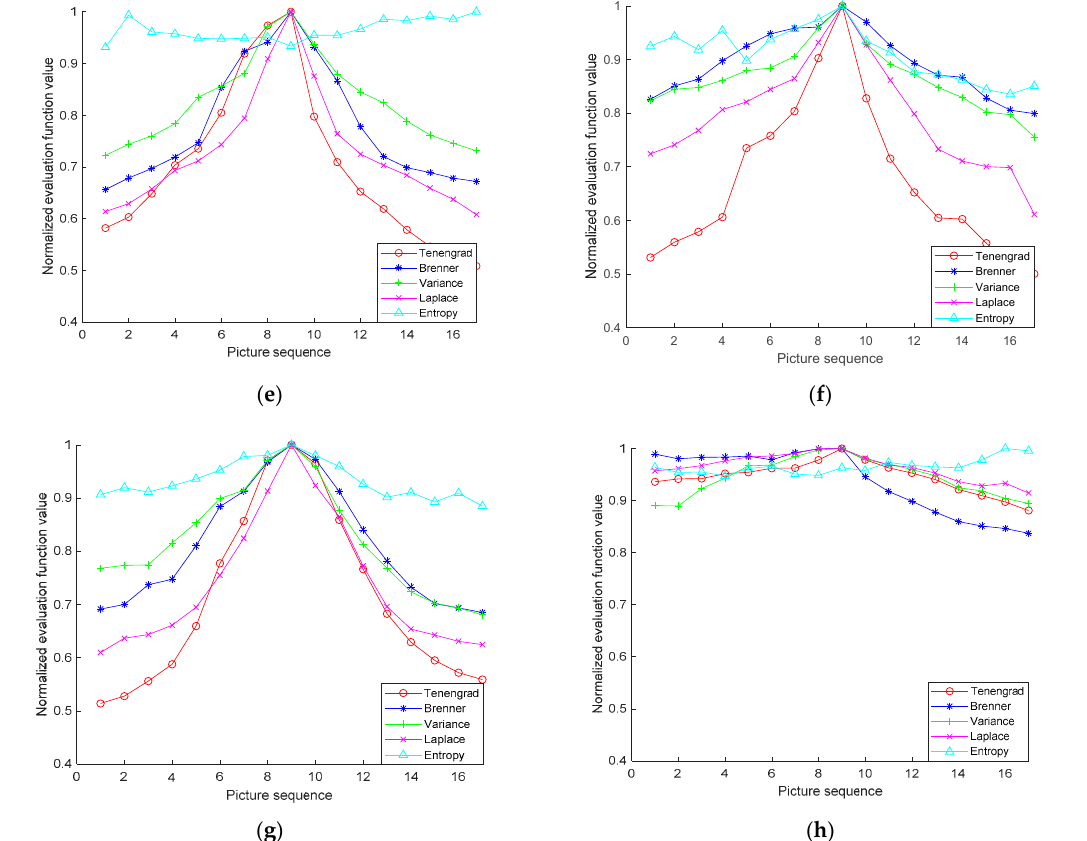
Figure 4. Comparison of different IEFs, corresponding to the scenarios shown in Figure 3.